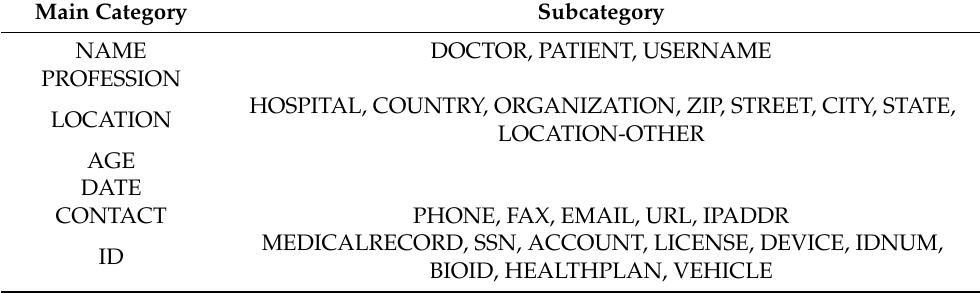
Table 1. i2b2-PHI Table 1. i2b2-PHI categories.